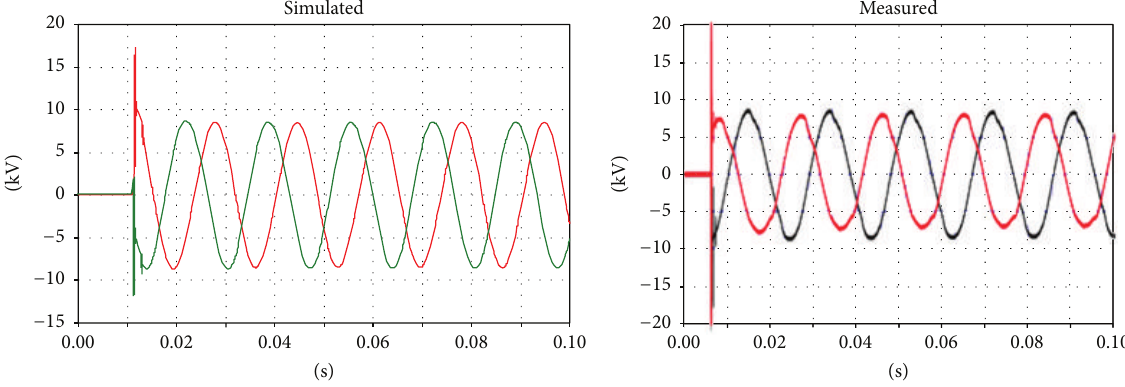
Figure 10: Voltage on the primary side of the transformer; phases U and V.